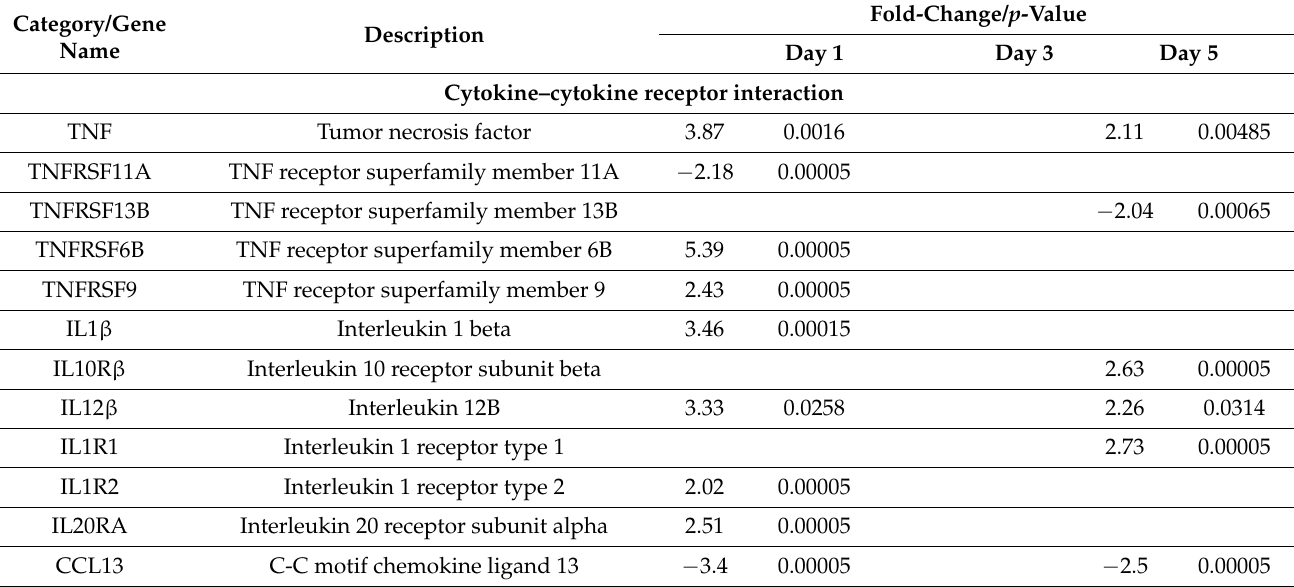
Table 2. Summary of DEGs in immune-related KEGG